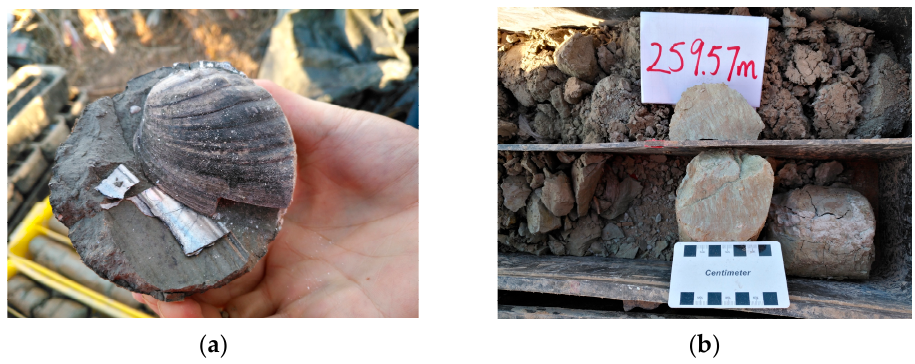
Figure 2. Combined borehole profile of key tectonic site.